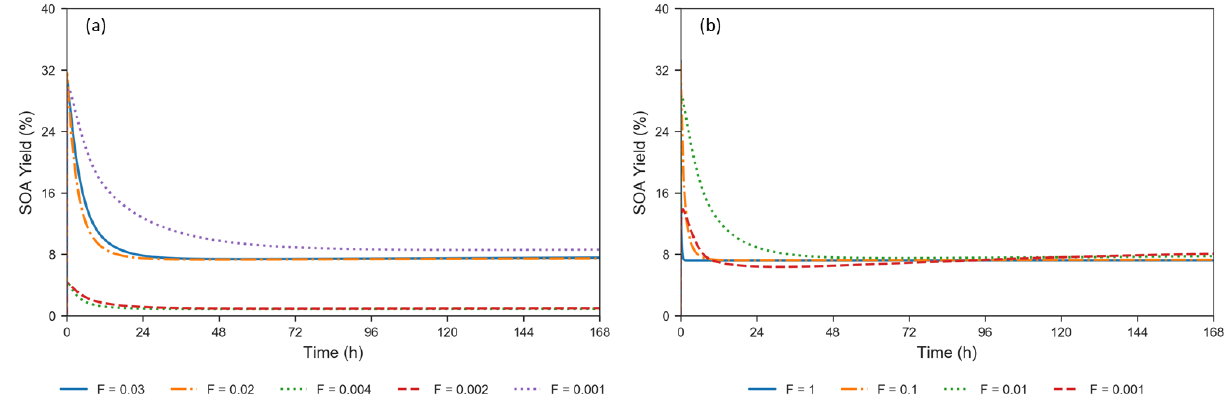
Figure 4. (a) Evolution of SOA yields from LEV degradation using valid simulations (conditions from Hennigan et al., 2010, when F = 0 . 02– 0.03 and α = 0 . 1; from Lai et al., 2014, when F = 0 . 002–0.004 and α = 0 . 01; and from Pratap et al., 2019, when F = 0 . 001 and α = 0 . 01). (b) Effect of varying the heterogeneous reaction rate coefficient by 4 orders of magnitude, at a constant mass accommodation coefficient ( α = 0 . 1) (conditions from Hennigan et al.,